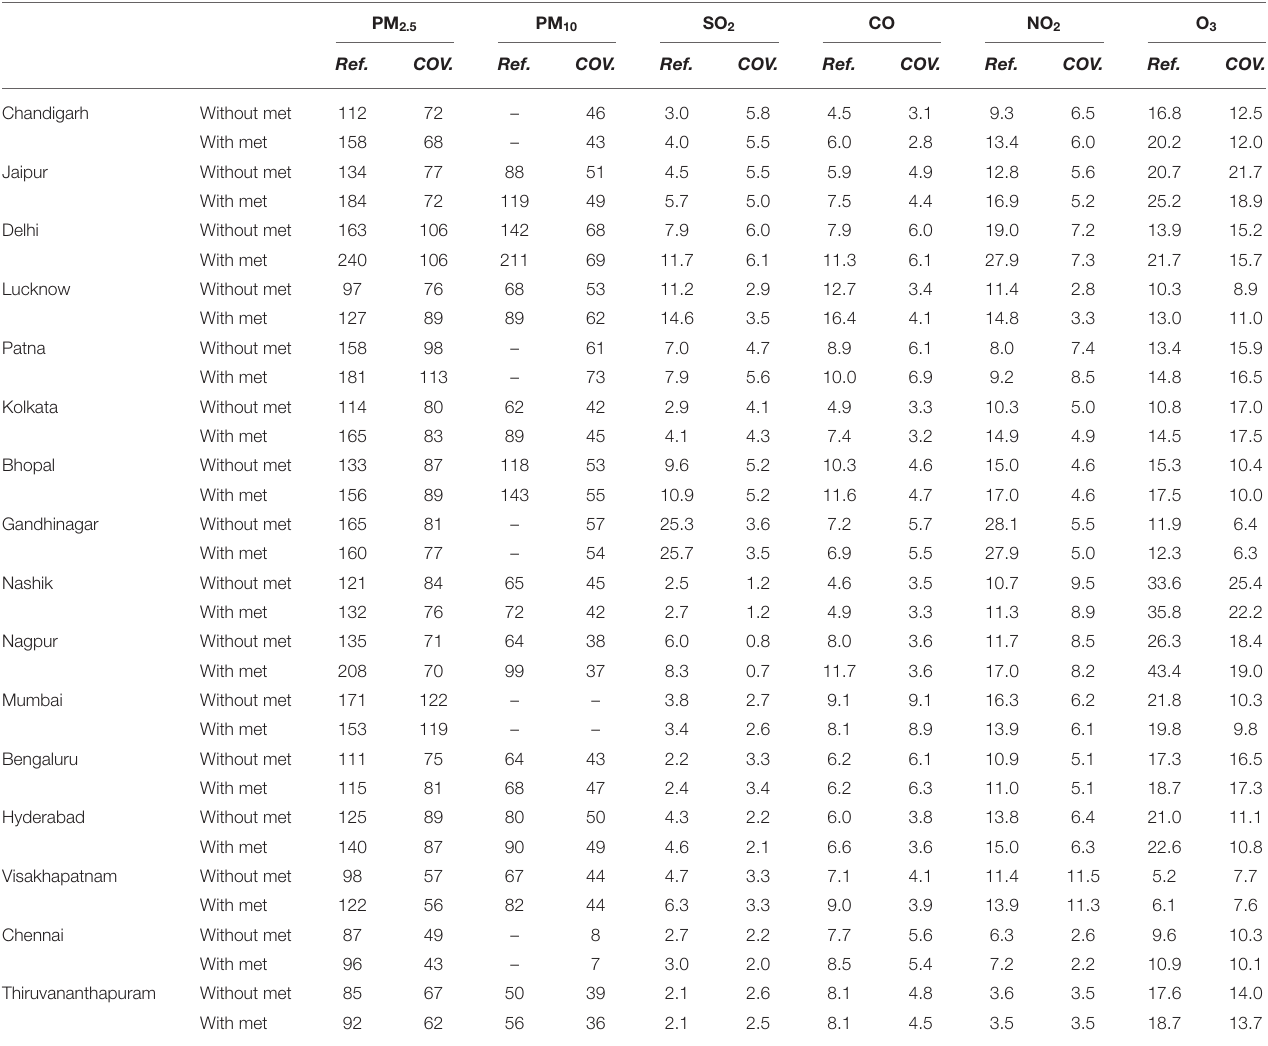
TABLE 3 | Mean EPA AQI values of various air pollutants (with and without normalization to meteorological parameter) during complete lockdown period (in 2020, as Cov.) and reference period (as Ref.). PM 2.5 PM 10 SO 2 CO NO 2 O 3 Ref. COV. Ref. COV. Ref. COV. Ref. COV.